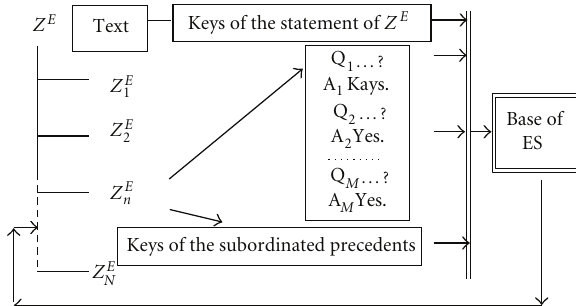
Figure 15: The work with keys of